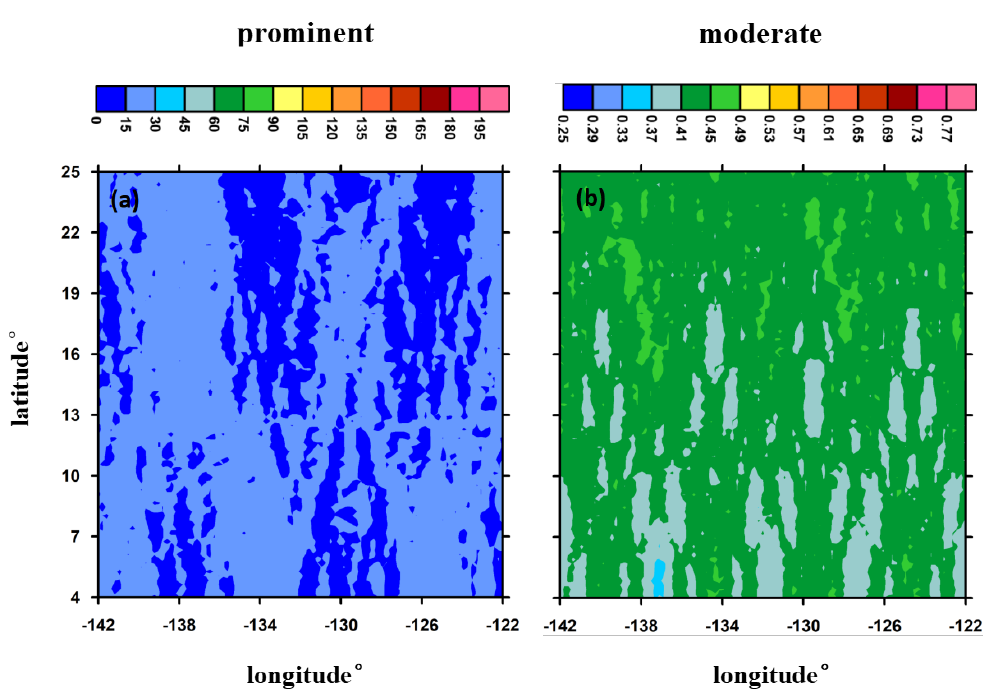
Figure 10. The RFI map of the area in the central Pacific. ( a ) The prominent RFI map and ( b ) the moderate RFI map are merged RFI maps of the tested area in the central Pacific within the range of 4 ◦ N–25 ◦ N, 142 ◦ W–122 ◦ W from 11 to 19 June 2018. All images have been truncated within the tested